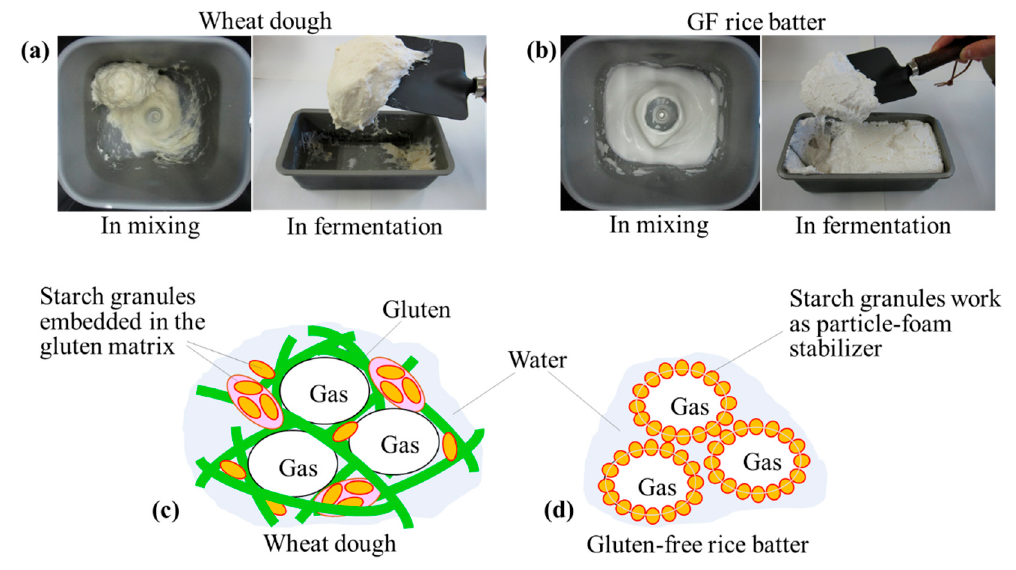
Figure 1. Comparison of wheat dough ( a ) and gluten-free rice batter ( b ) during mixing and fermentation. The drawings show the gas-holding mechanisms of wheat dough ( c ) and gluten-free rice batter ( d ). Adapted from ref. 9 with permission.